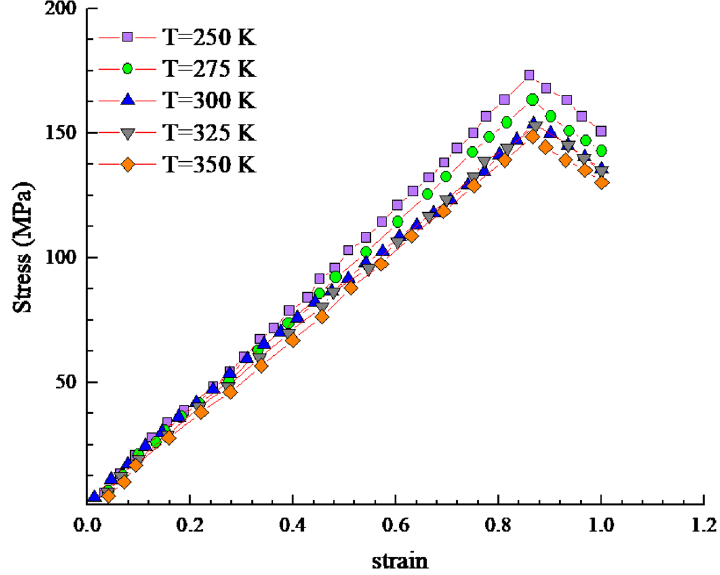
Figure 8. BAG’s stress–strain curve in terms of initial temperature in the MD box.